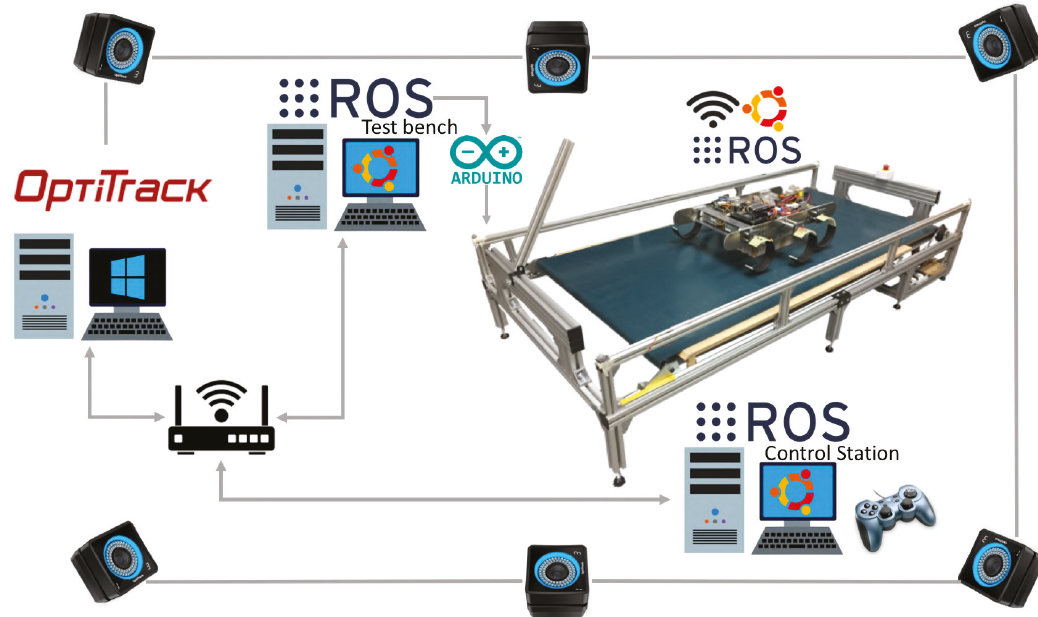
Figure 12. Schema of all the system for the indoor tests with the test bench.